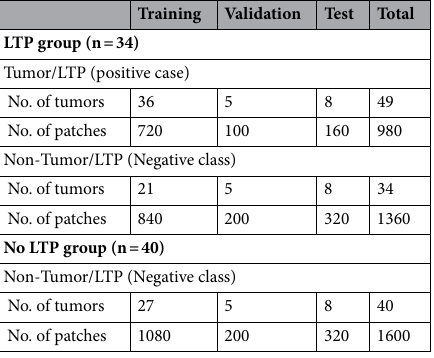
Table 3. Patient and data distribution of 74 patients used for training and testing. LTP, local tumor